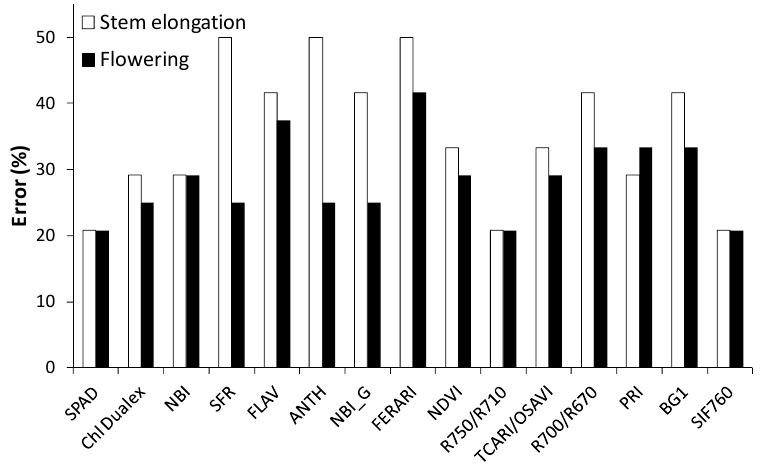
Figure 8. Error percentage of the various indices tested when distinguishing between N-sufficient and N-deficient plots at maize stem elongation and at